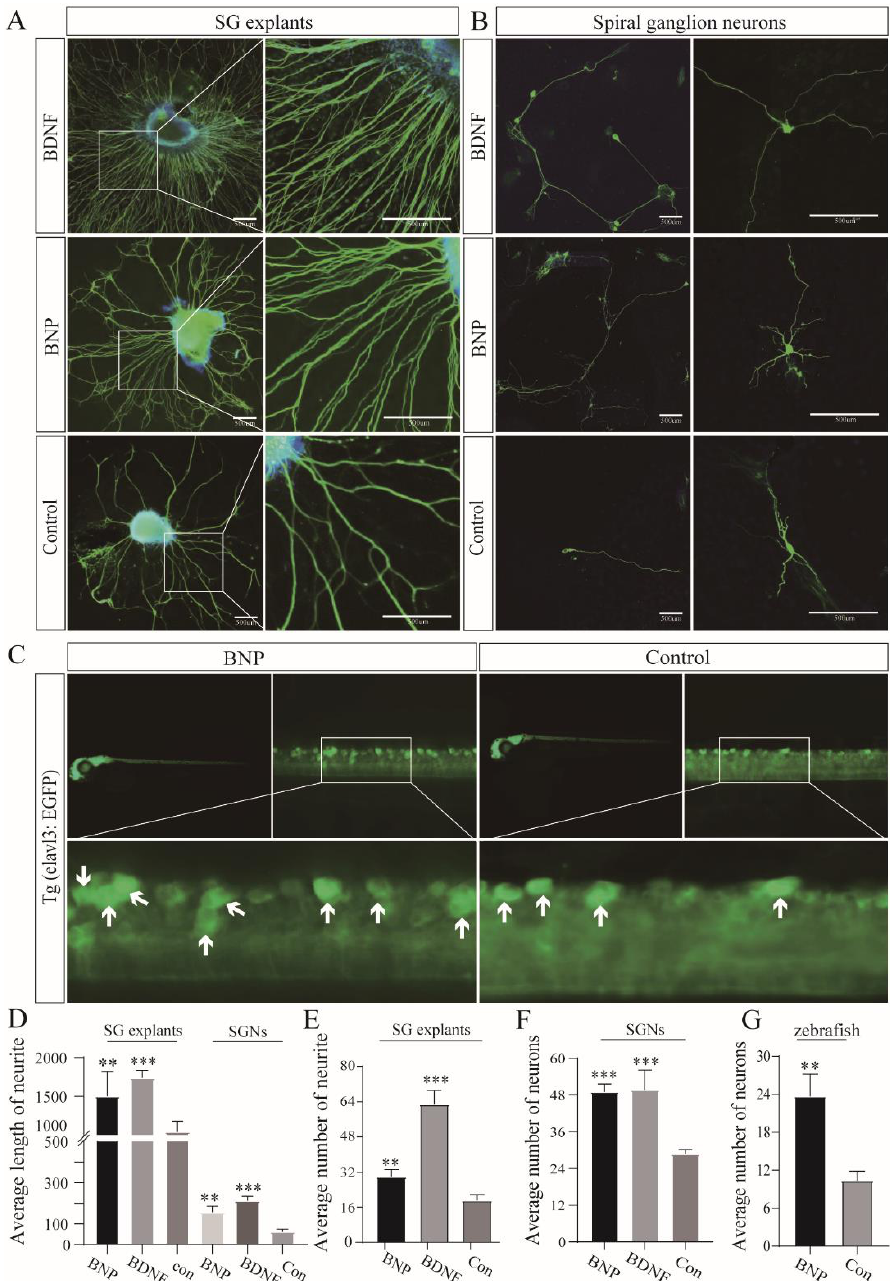
Figure 2. BNP promotes neurite growth and survival of cochlear spiral ganglion neurons. ( A ) Im- munofluorescence analysis of neurite length and number of spiral ganglion (SG) explants cultured in 20 ng/mL BDNF, 1 µ M BNP and no supplement. Scale bar: 500 µ m. ( B ) The number of neurons and the length of neurites were observed by fluorescence immunostaining. Scale bar: 500 µ m. ( C ) Neuron number counting of zebrafish with fluorescently labeled neurons cultured in 1 µ M BNP group and the control group. Arrows indicate complete and countable neurons. ( D ) Left, comparison of neurite length between SG explants cultured in 20 ng/mL BDNF, 1 µ M BNP and no supplement medium. Right, comparison of neurite growth length of single neuron cultured in 20 ng/mL BDNF, 1 µ M BNP and no supplement. ( E ) The number of neurites in SG explants was compared under three culture conditions. ( F ) Comparison of the number of single neuron cultures three different conditions. ( G ) Comparison of neuron counts in zebrafish cultured in 1 µ M BNP and no supplement medium. All of the data are presented as the mean ± SD of three independent experiments. **, p <